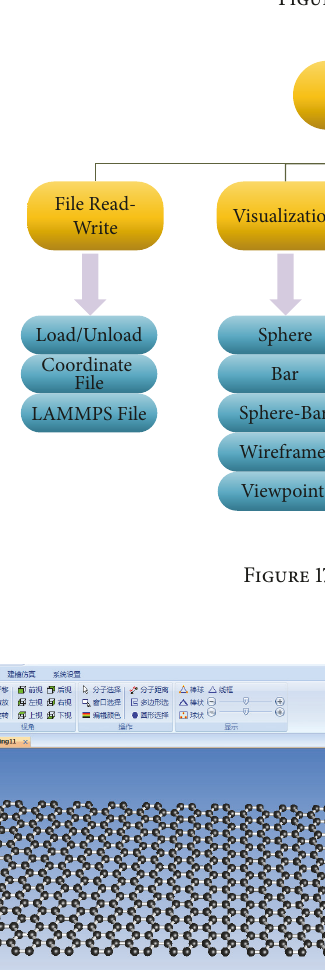
Figure 16: The running process of LAMMPS.